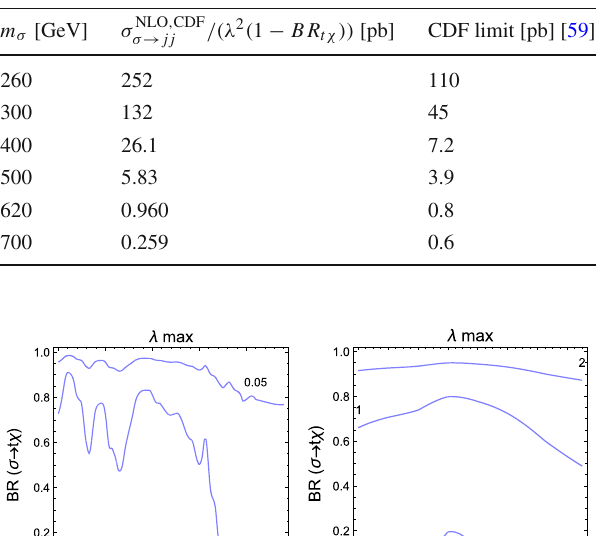
Table 1 Fiducial cross sections for dijet production at the TeVatron, in √ p ¯ p collisionsat s = 1 . 96TeV,afterimposingthesamejetreconstruc- tion method and signal selection as in the CDF analysis of Ref. [59]. We compare our (normalised) predictions with the CDF limits